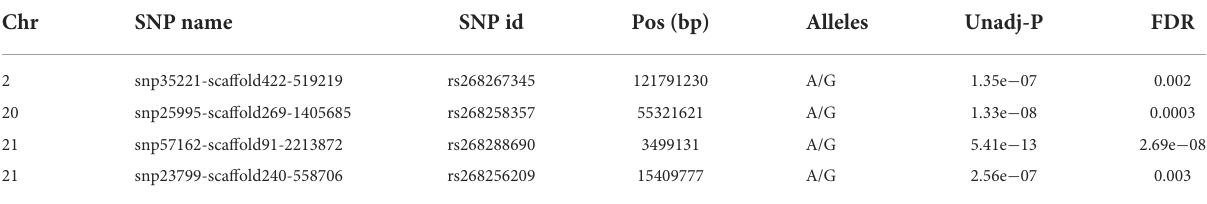
TABLE 2 Genome-wide association study identifies four SNPs significantly associated with the predicted breeding value of litter size at birth (LSB) in Markhoz goats. Chr